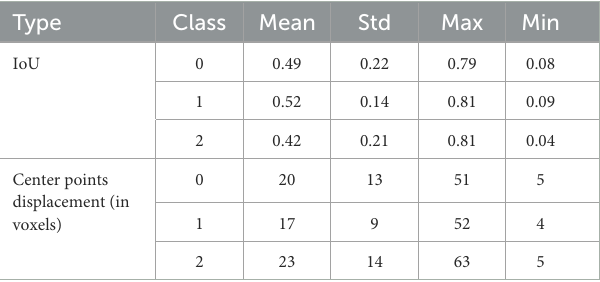
and a dimension of (256, 256, and 19) voxels on the sagittal, coronal and axial planes respectively. Ground truth labels are obtained from